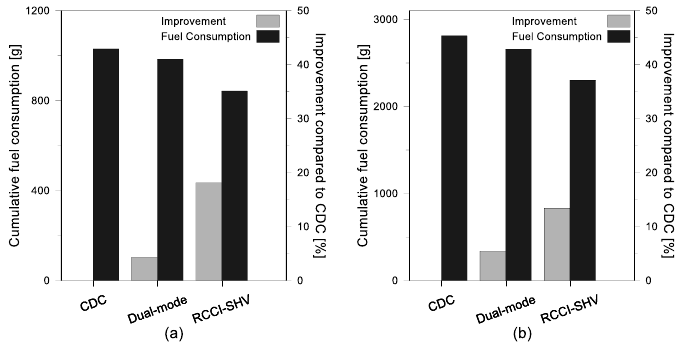
Figure 14. Cumulative fuel consumption and fuel savings for WLTC ( a ) and RDE ( b ) driving cycles.